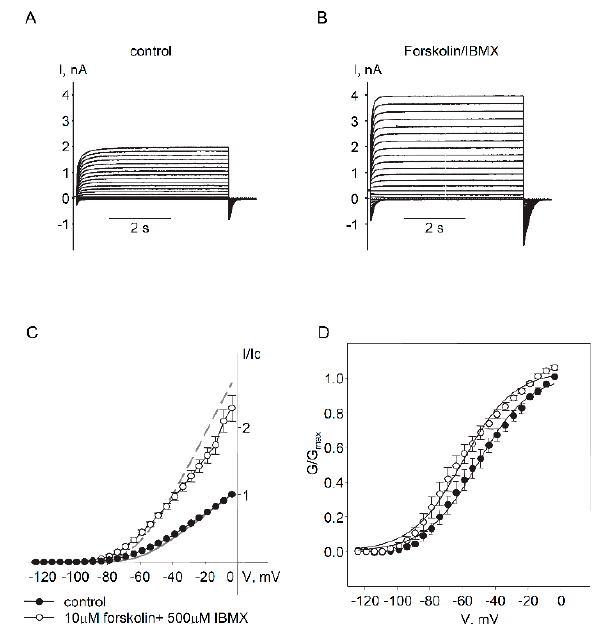
Figure 5. The enhancement of currents by forskolin/IBMX was not significantly affected by mutation of all six putative C-terminal PKA phosphorylation sites of Kv7.5 channels. Upper panels: representative current traces through mutant Kv7.5 C-term 6xS → A channel (C = 84 pF) in control ( A ) and in the presence of 10 µM forskolin in combination with 500 µM IBMX ( B ). ( C ) I–V relationships of Kv7.5 C-term 6xS → A current recorded before (filled circles, n = 5) and after (open circles, n = 5) application of forskolin (10 µM) in combination with IBMX (500 µM) for 5 min. I–V of wild-type Kv7.5 channels are shown in grey solid line (control) and grey dashed line (forskolin/IBMX-treated) for comparison. ( D ) Mean fractional conductance plots calculated from tail currents measured before (control, filled circles) and after 5 min in forskolin/IBMX (open circles), fitted to a Boltzmann distribution (V 0.5 = − 51.4 ± 3.2 mV in the absence, and − 61.7 ± 3.2 mV in the presence of forskolin/IBMX, n = 5, p = 0.016, paired Student’s t- test).